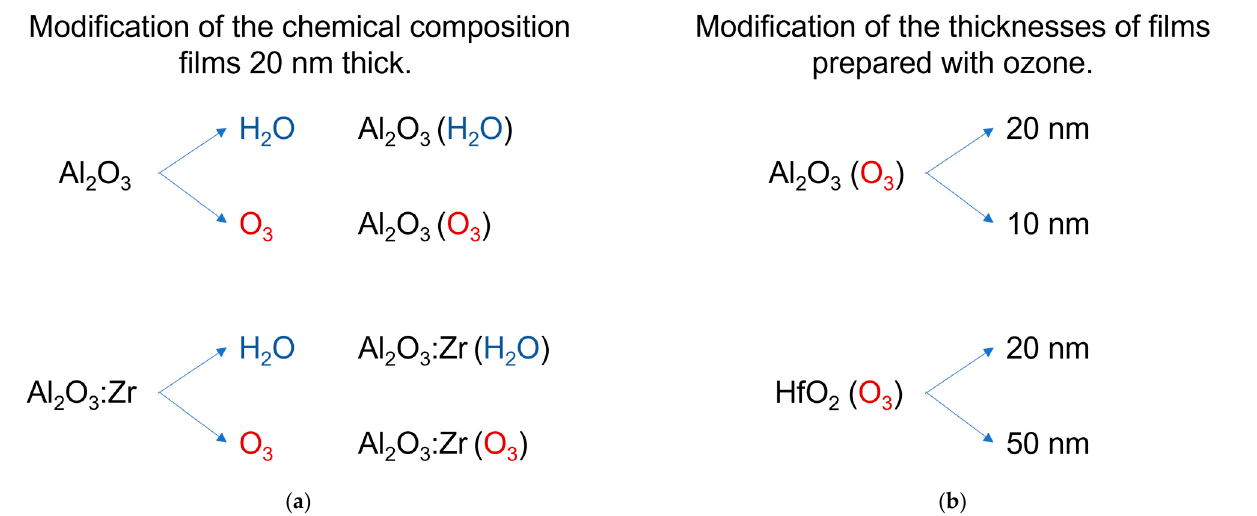
Figure 1. List of the samples investigated in this work: ( a ) modification of the chemical composition of films, ( b ) modification of the thicknesses of films.